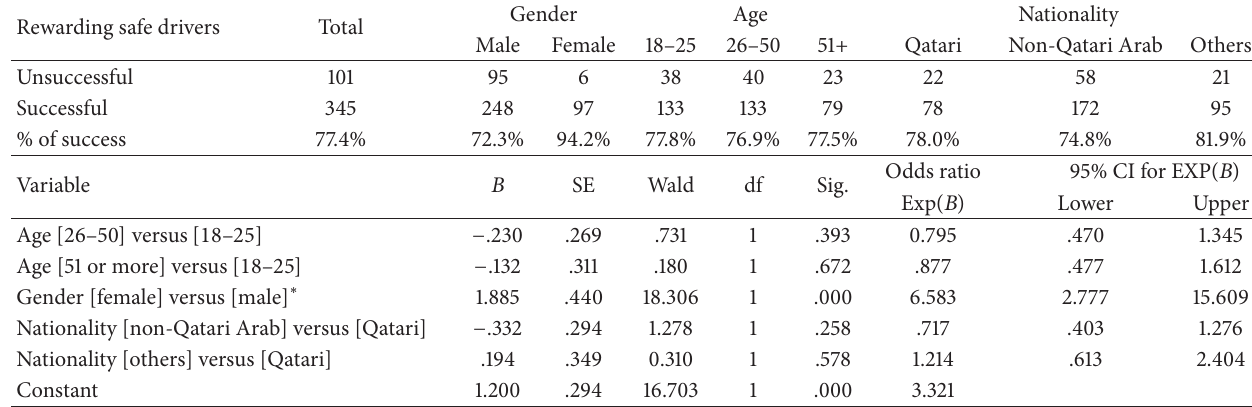
Table 8: Reported success and logistic model results for the rewarding safe drivers